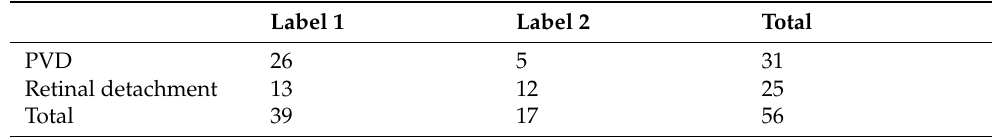
Table 2. Confusion matrix for swept-source OCT